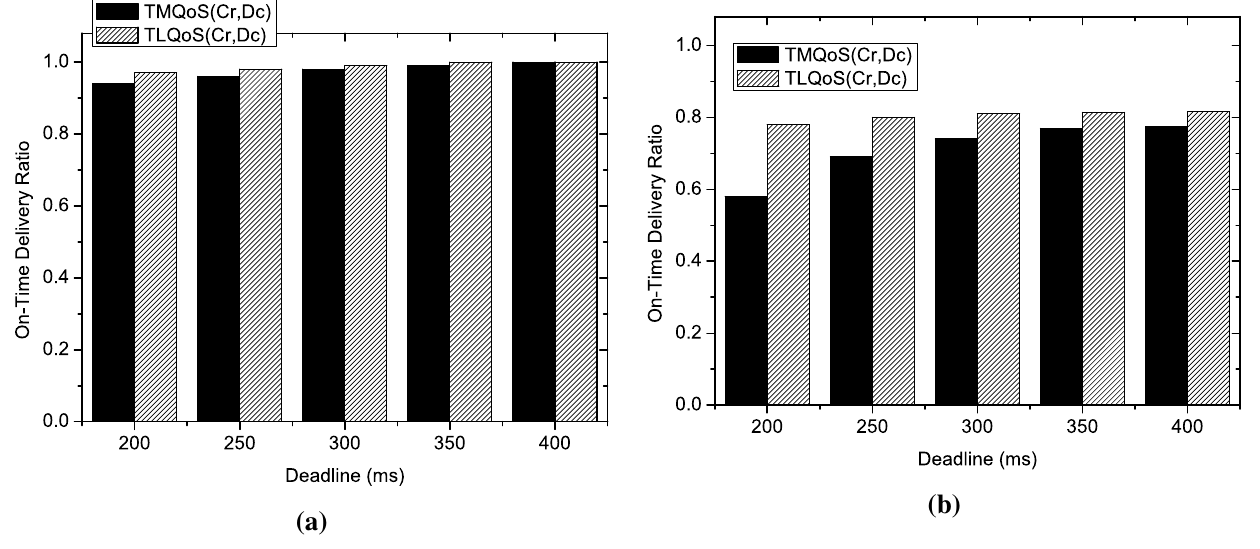
Figure 6. Performance Comparison varying delay deadline. ( a ) On-Time packet delivery ratio varying delay deadline at moderate traffic load; ( b ) On-Time packet delivery ratio varying delay deadline at high traffic